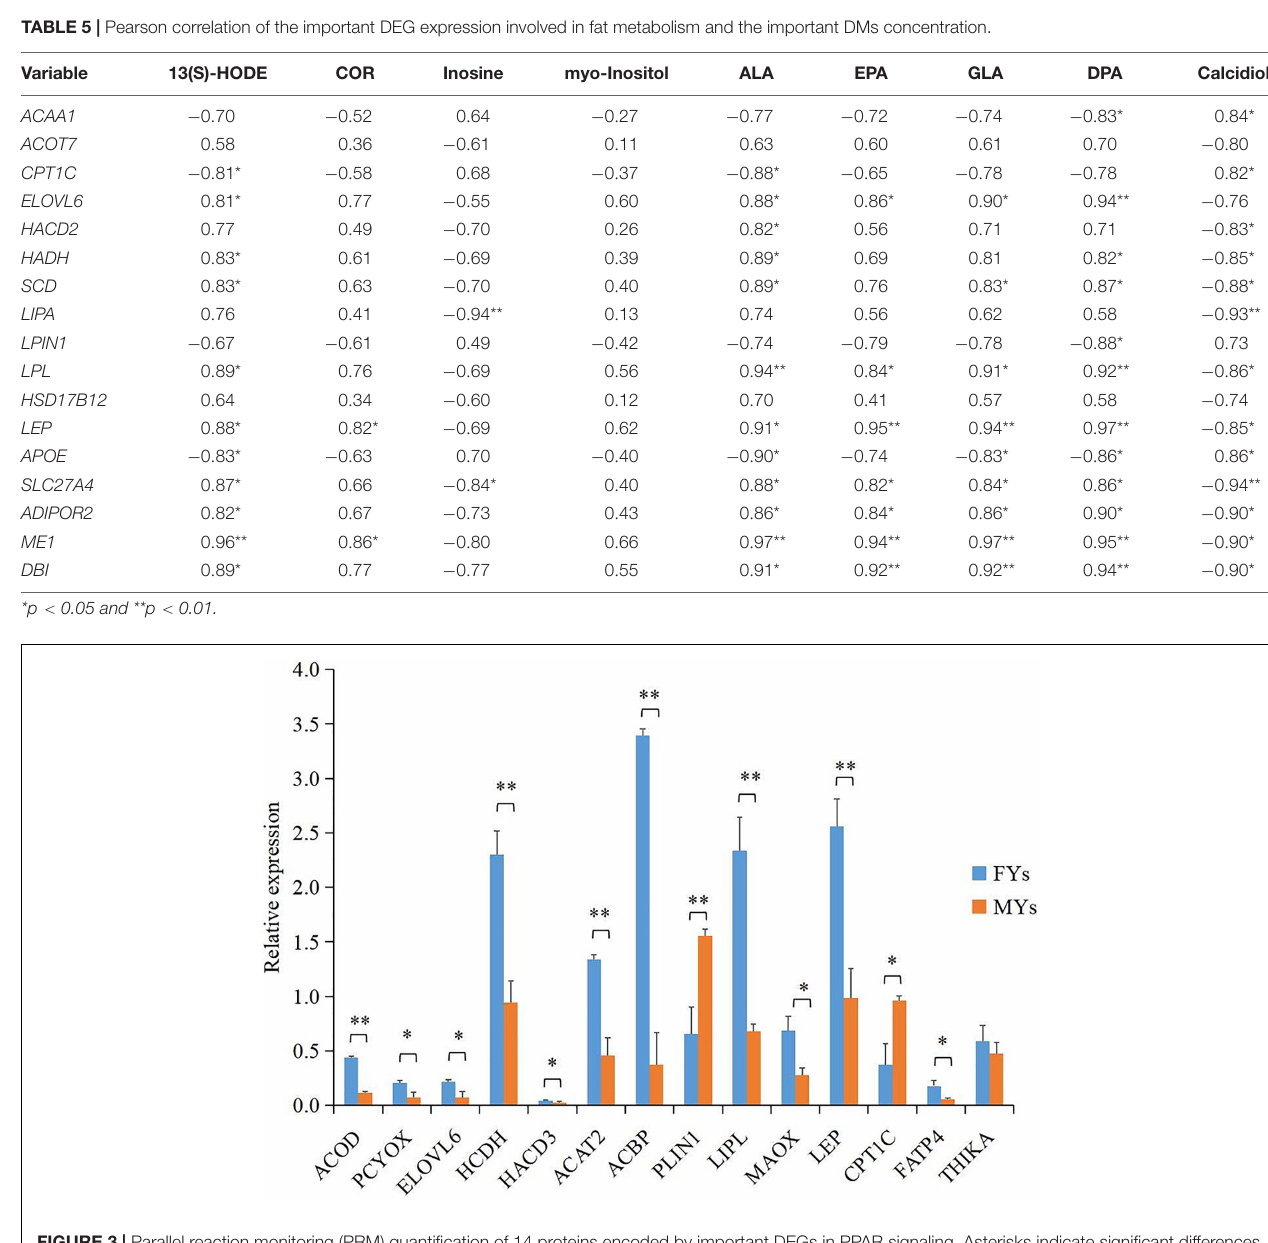
FIGURE 3 | Parallel reaction monitoring (PRM) quantification of 14 proteins encoded by important DEGs in PPAR signaling. Asterisks indicate significant differences in proteins’ relative expression in subcutaneous fat between the FY and MY groups. ∗ p < 0.05 and ∗∗ p <